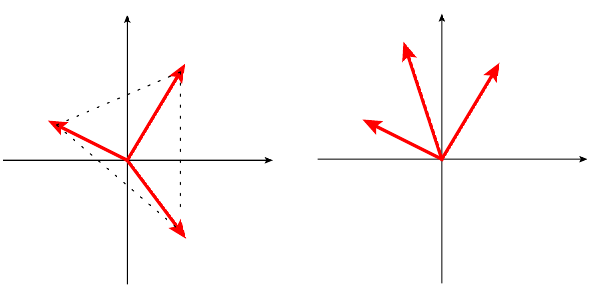
Figure 4 . The convex hull of these three vectors encloses the origin, and hence trivially covers the entire two-dimensional